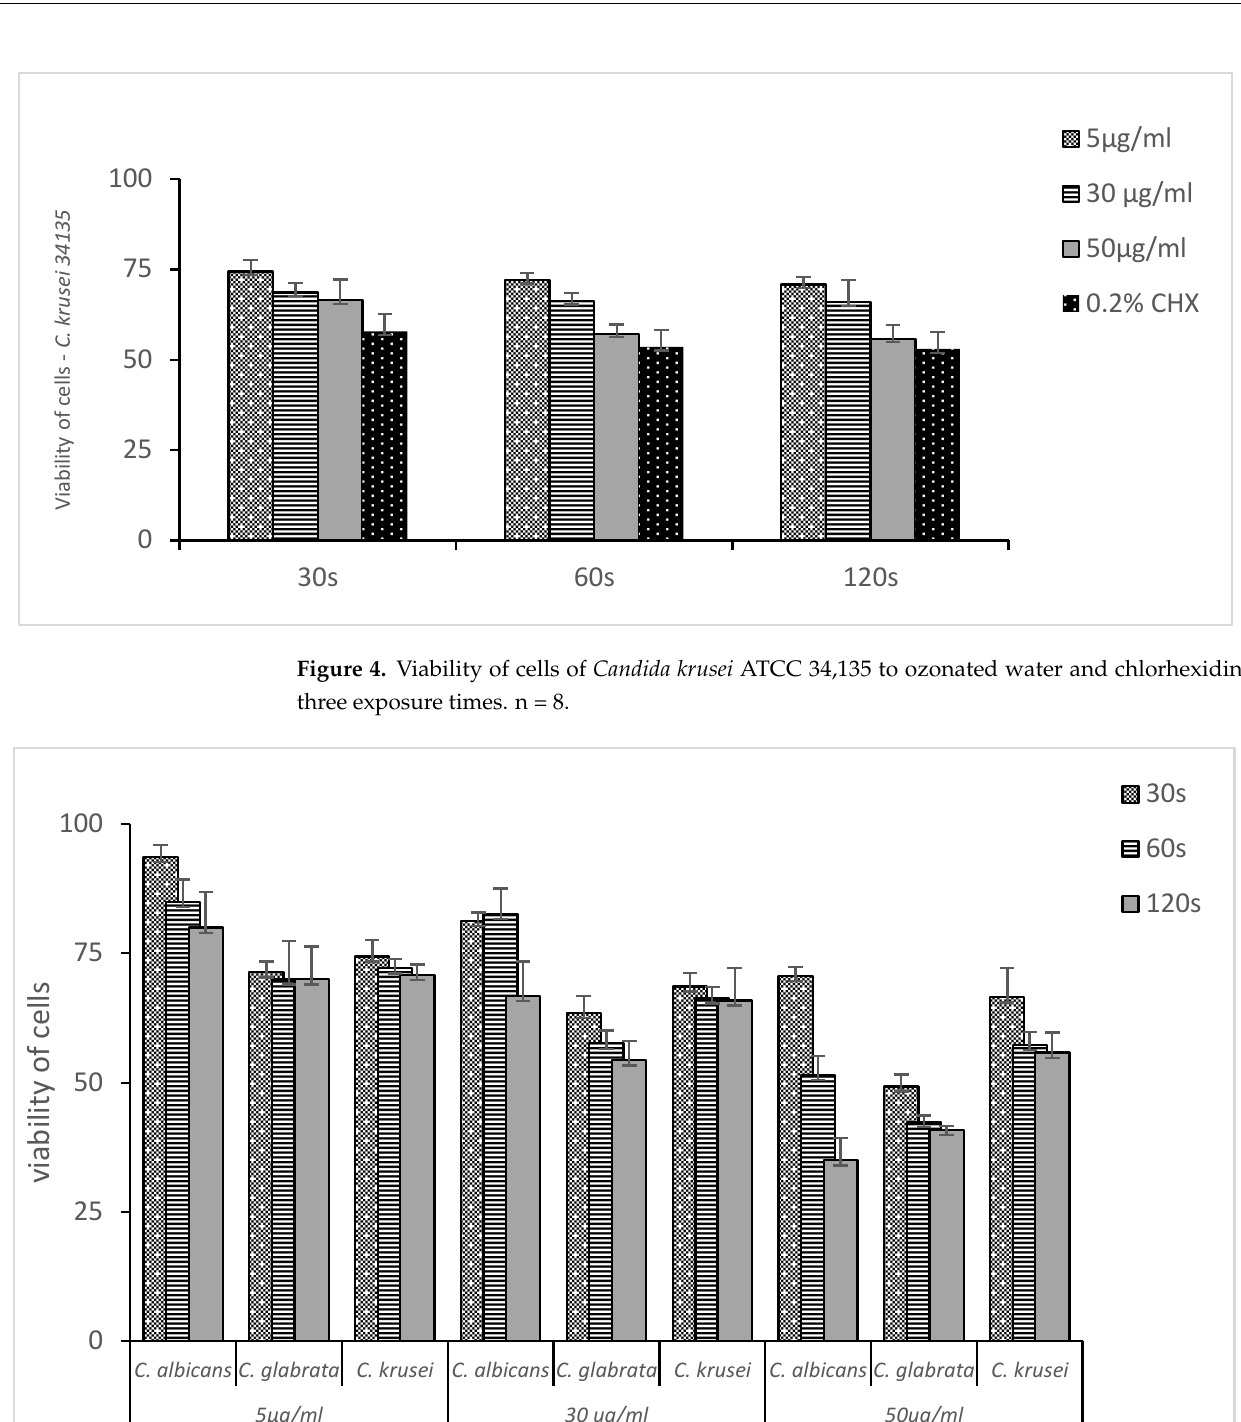
Figure 3. Viability of cells of Candida glabrata ATCC 2001 to ozonated water and chlorhexidine in three exposure times. n = 8.